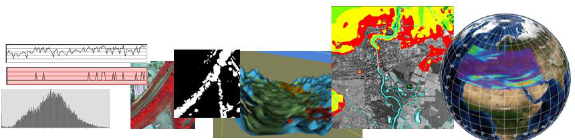
Figure 6. Sample WCPS retrieval results (source: